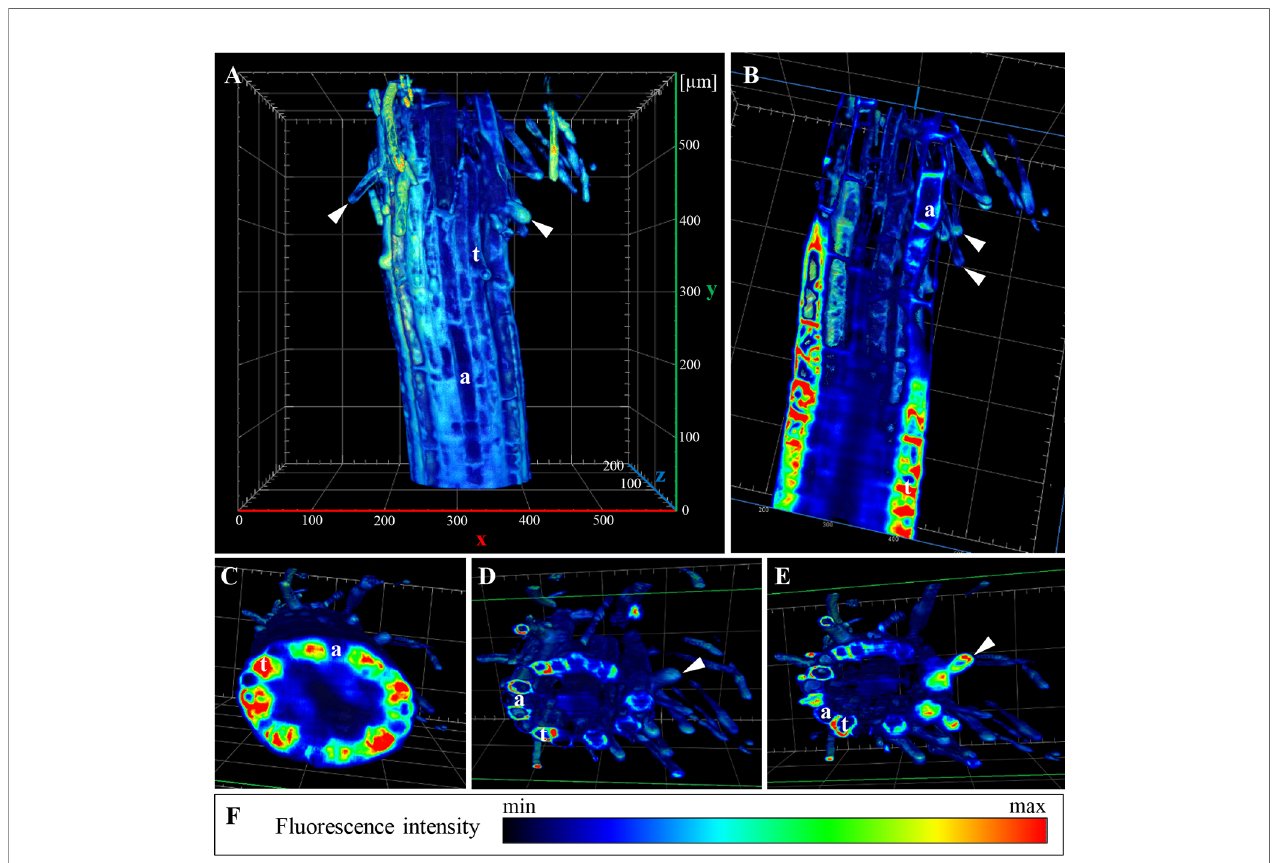
FIGURE 6 | 3-D rendering of ANN1-GFP distribution in A. thaliana primary root stably expressing proANN1::ANN1:GFP construct. Data were obtained by Luxendo MuVI SPIM and after post-processing 3-D reconstruction was made by Arivis. (A) Overview of the elongation and differentiation zone of the primary root with root hairs (arrowheads) in different stages of their development. (B) Clipping of the 3-D model against z-plane revealed the highest fl uorescence intensity of ANN1-GFP (red in pseudocolored intensity scale) in trichoblast cell fi les (t). (C – E) Clipping of the 3-D model against y-plane, where in (C) the lowest plane shows root cross- section at the elongation zone with a different distribution of ANN1-GFP in trichoblasts (t) and atrichoblasts (a). (D, E) 3-D projections displaying root cross-sections at the differentiation zone, arrowhead indicates growing root hair, whereas y-clipping along its longitudinal plane point to ANN1-GFP accumulation in root hair tip. (F) Heat map presents ANN1-GFP fl uorescence intensity in pseudocolors with the lowest fl uorescence intensity corresponding to black and highest fl uorescence intensity corresponding to red color. Arrowheads point root hair tips, (t) points trichoblasts, and (a)